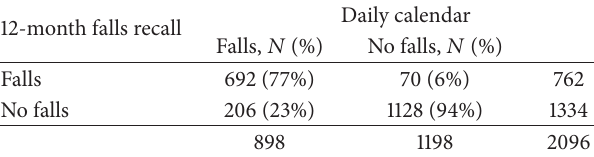
Table 2: Table of frequencies: fallers and